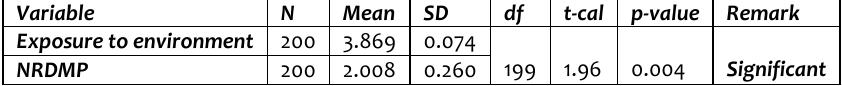
Table 1 : t-test summary on the exposure to environment for numerical reasoning